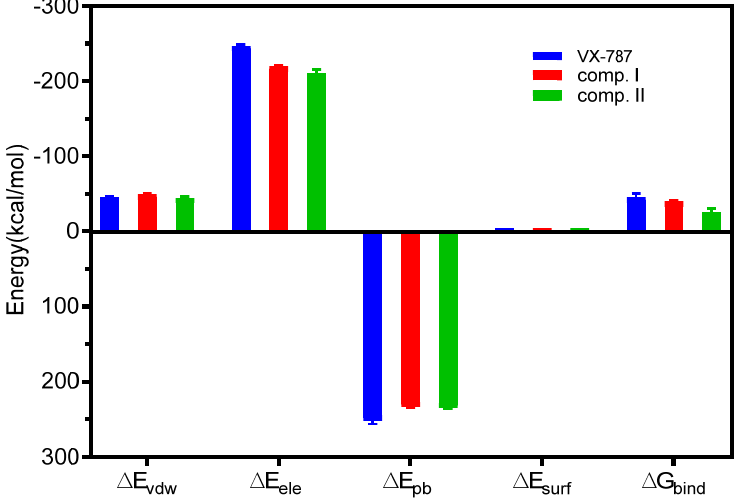
Figure 8. Calculated energy contribution decomposition values of binding − free energies by the MMPBSA method (All in kcal/mol).